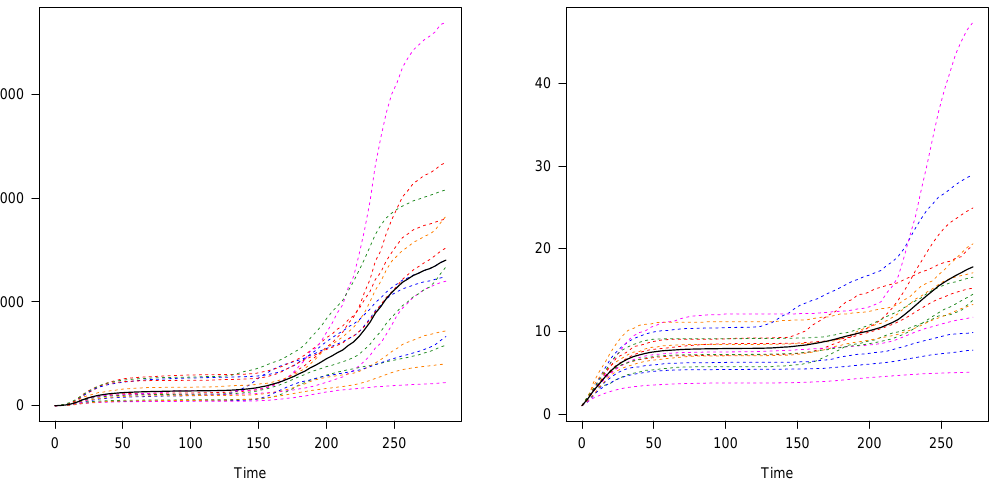
Figure 2. Number of infected individuals ( left ) and deaths ( right ) corresponding to the first two waves of the pandemic in Spain. The solid black lines represent the sample